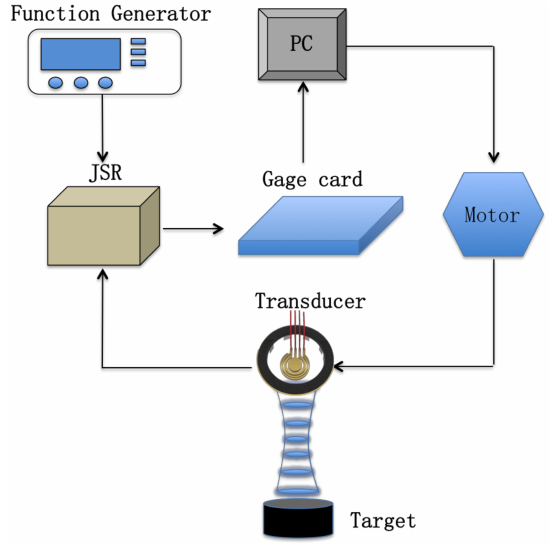
Figure 5. Schematic of the test system setup for pulse-echo detecting and ultrasonic imaging.